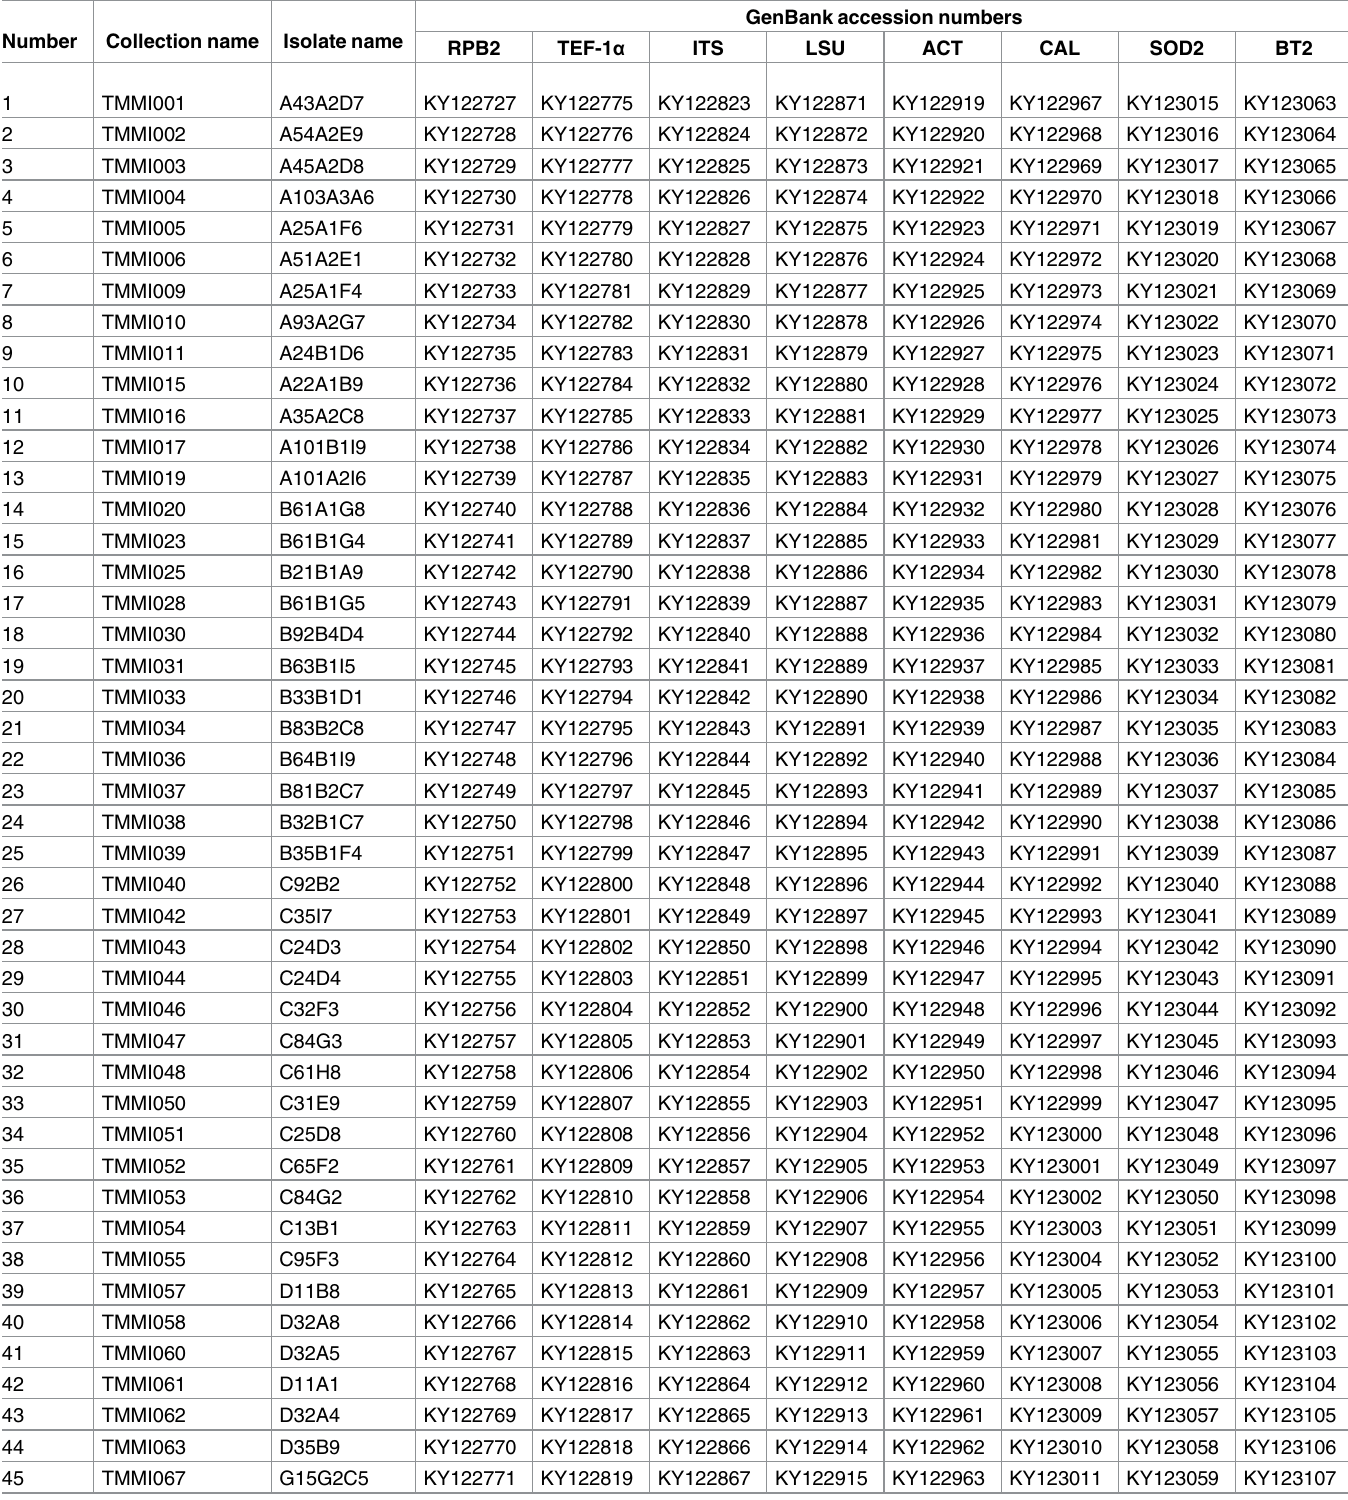
Table 1. GenBank accessionnumbers of